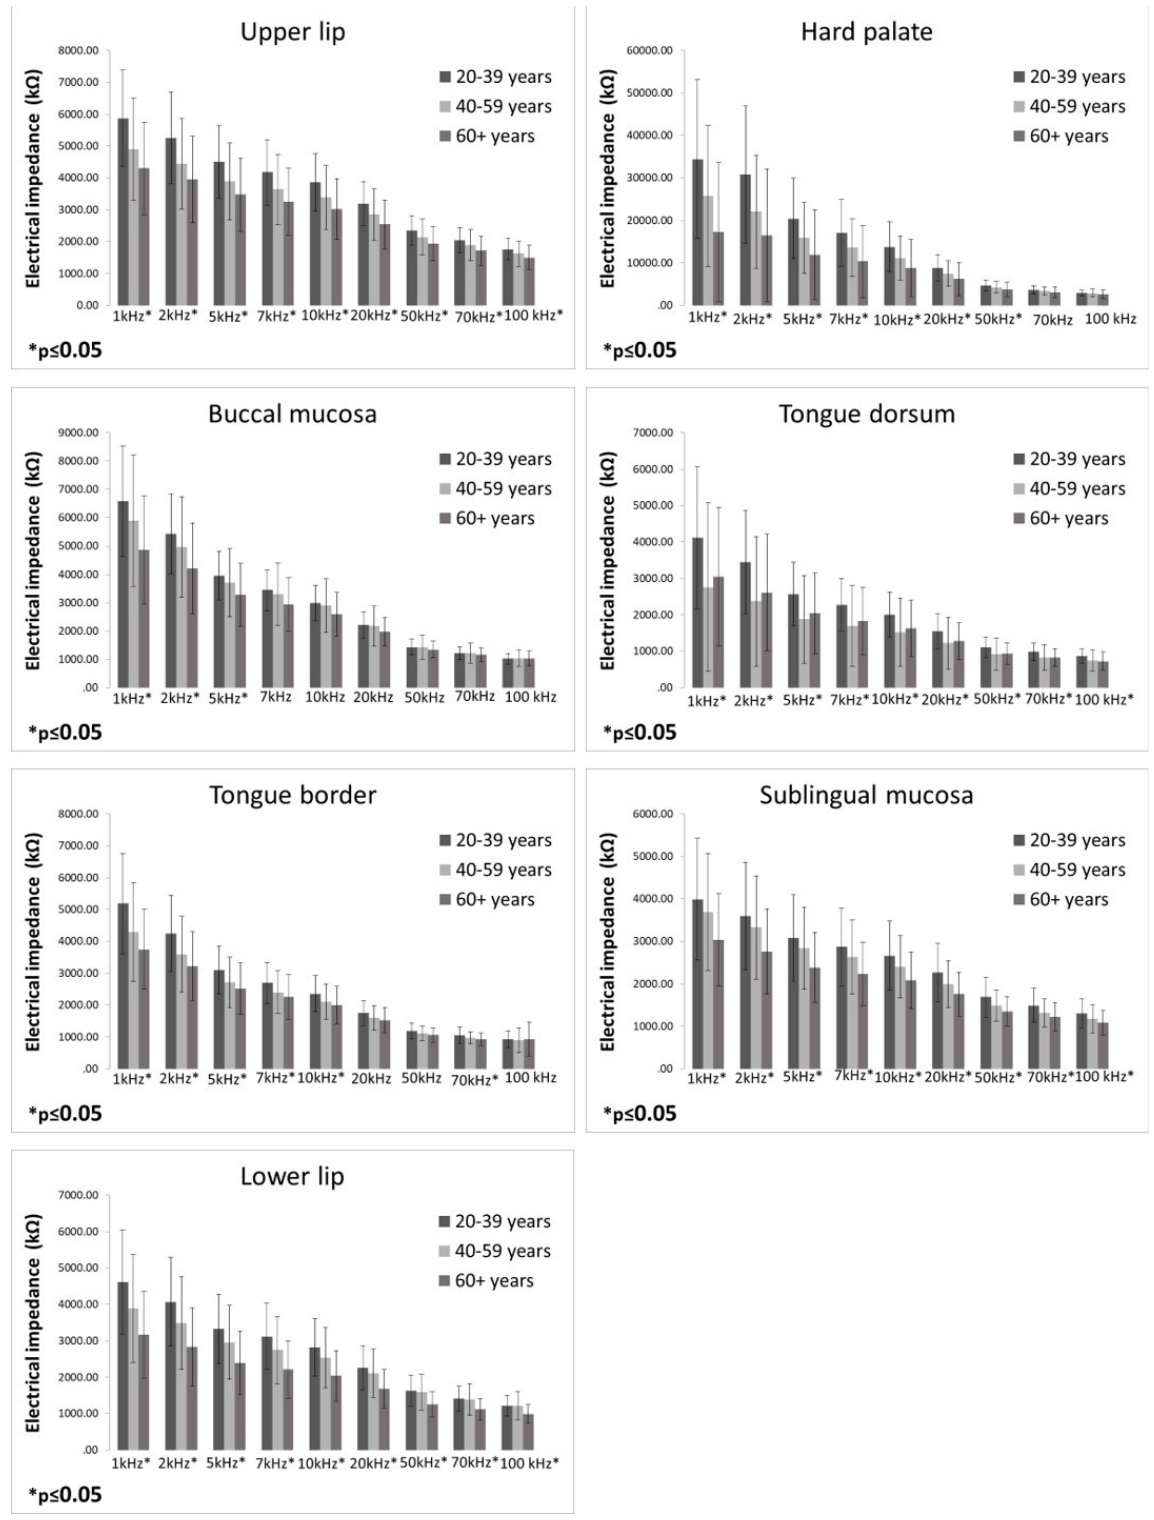
Figure 2. Electrical impedance measurements in three different age groups (bars represent mean ± standard deviation).